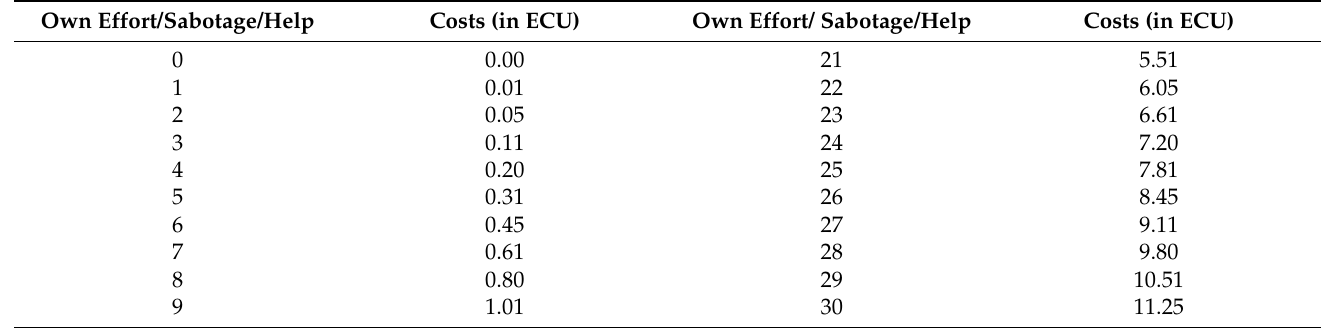
Table A3. Overview of costs (in ECU) for own work effort and